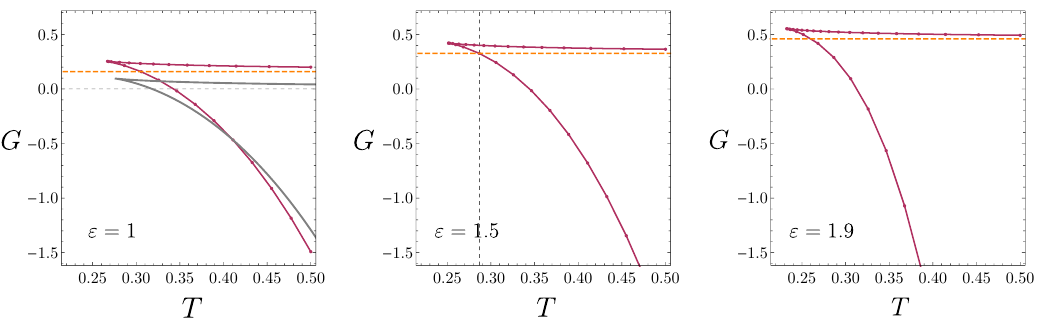
Figure 12 . Left : Gibbs free energy for the black holes against temperature for a (cid:12)xed boundary rotation parameter " = 1 (red data points). The orange gridline shows the value for the correspond- ing AdS 4 soliton with the same " . The grey solid curve traces the values of Schwarzschild-AdS 4 , and the grey-dashed gridline shows G AdS = 0. Middle : similar plot for " = 1 : 5, with the horizontal gridline marking the intersection temperature T HP ( " ). To the right of this line the large black holes will be the dominant solutions, whilst solitons dominate to the left. Right : as we approach the critical value of " , the phase transition temperature decreases.